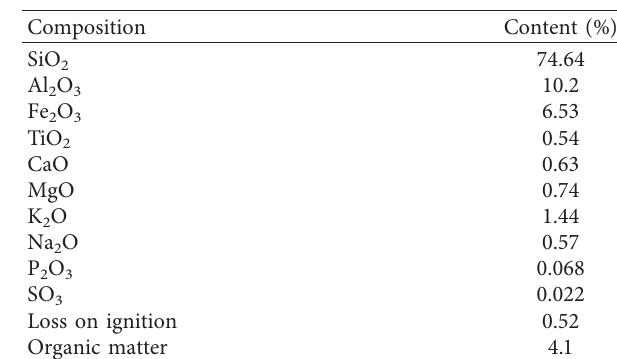
Table 2: The chemical composition of test soil.